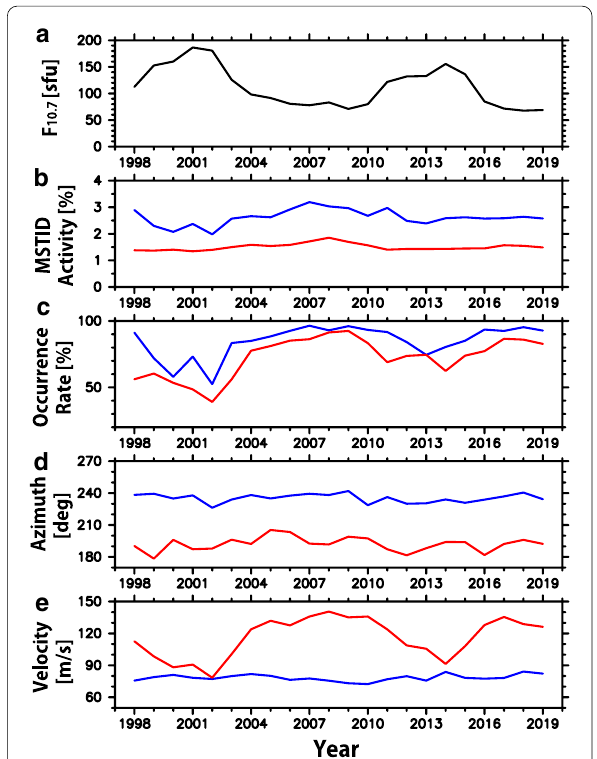
Fig. 6 Twenty-two year variations of yearly mean of a solar activity index, F 10.7 ; b MSTID activity; c MSTID occurrence rate; d and e horizontal propagation direction (azimuth clockwise from due north) and phase velocity of MSTID, respectively, between 1998 and 2019.